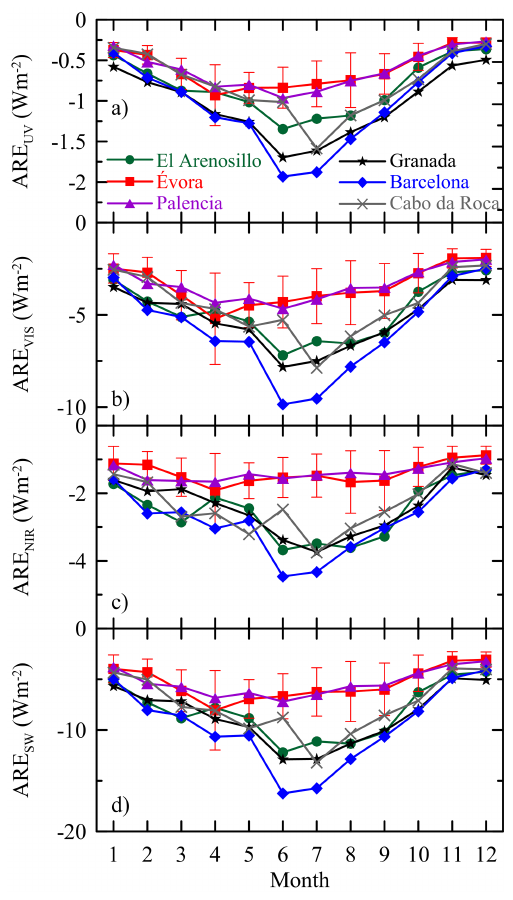
Figure 7. Annual cycle of ARE UV (a) , ARE VIS (b) , ARE NIR (c) , and ARE SW (d) at the six sites: Barcelona (blue diamonds), Pa- lencia (purple triangles), Évora (red squares), Cabo da Roca (grey crosses), Granada (black stars), and El Arenosillo (green circles). Vertical bars point out the standard deviation of each monthly value at the Évora